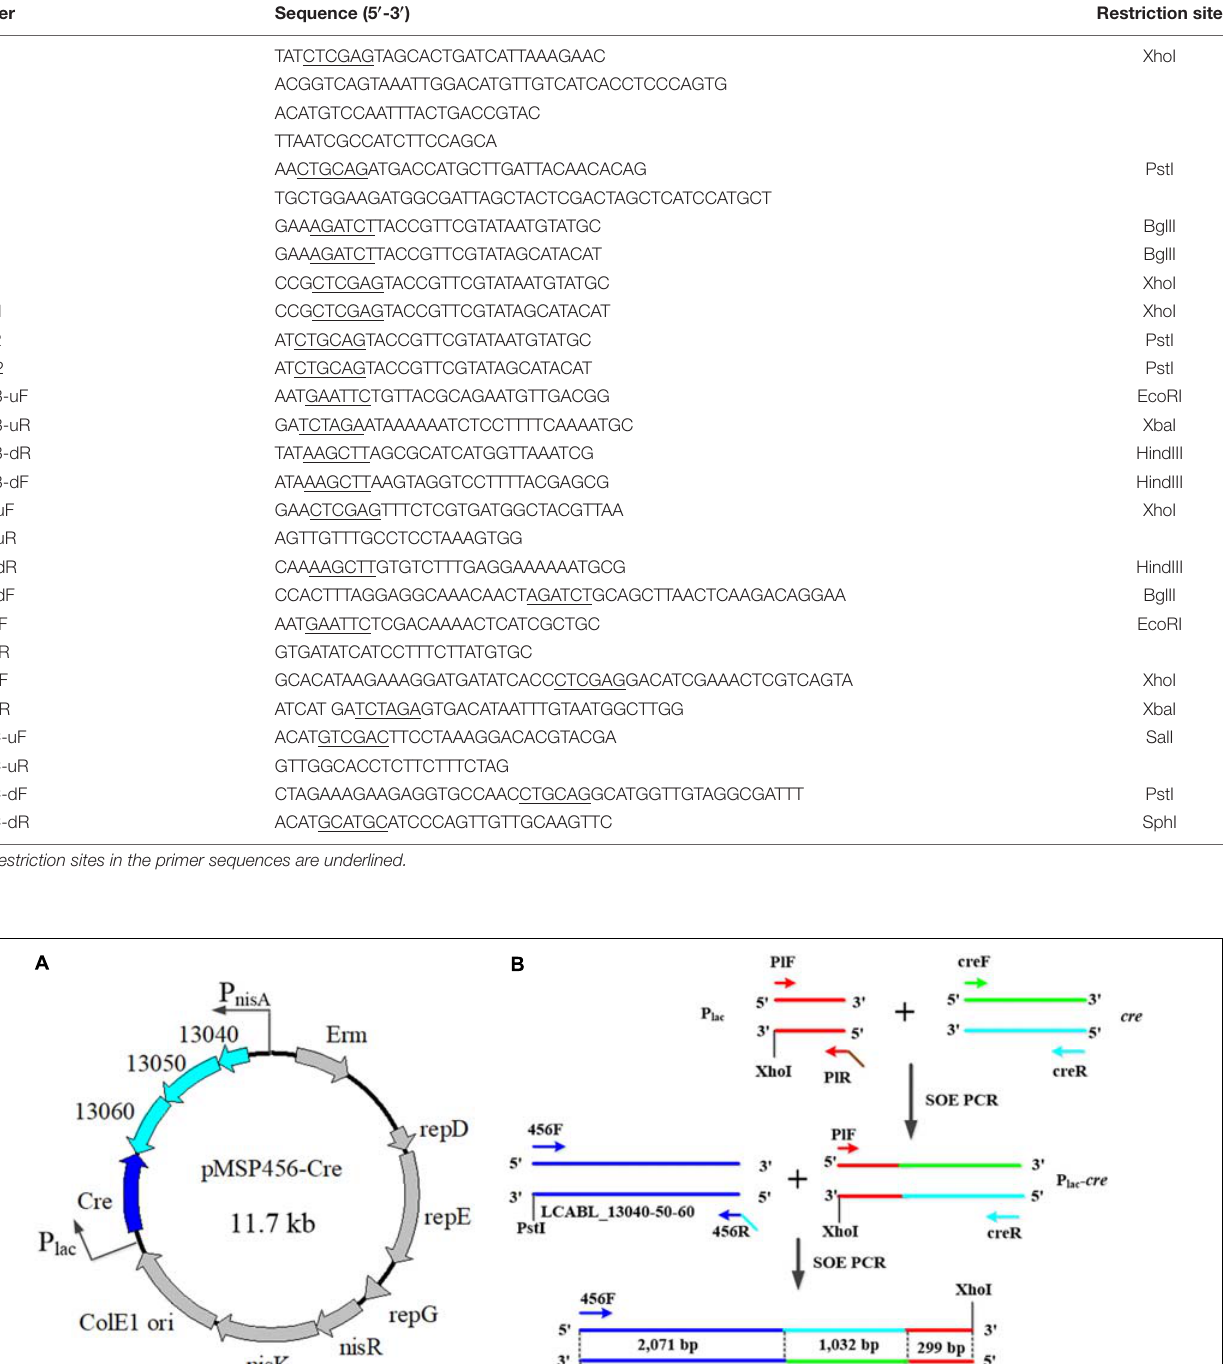
Frontiers in Microbiology |